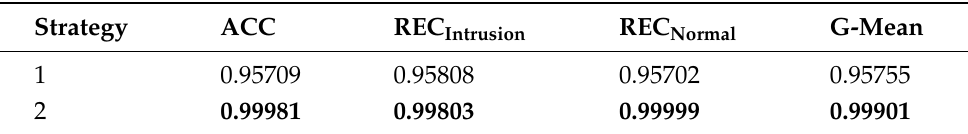
Figure 7. Evaluation of different oversampling ratio values for strategy 1. Table 4. Oversampling by SMOTE for SLFN of 150 neurons on different values of sampling strategy. Bold font indicates best